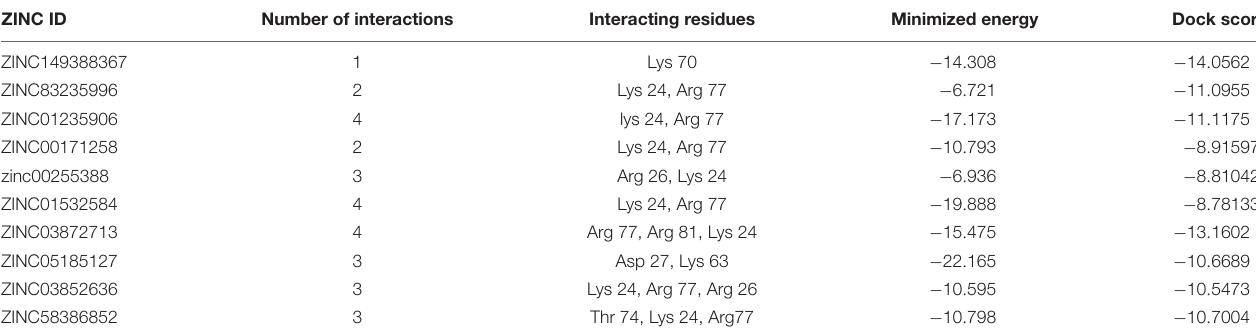
FIGURE 12 | Interaction of 2-isopropylmalate synthase with ZINC40448986 (colored in red). The interacting residues (green) are shown bonding (dotted lines) with the ligand. TABLE 15 | Ribosome-binding factor A and its interaction profile with docked compounds, their ZINC ID, minimized energy, number of interactions, dock score, and interactive